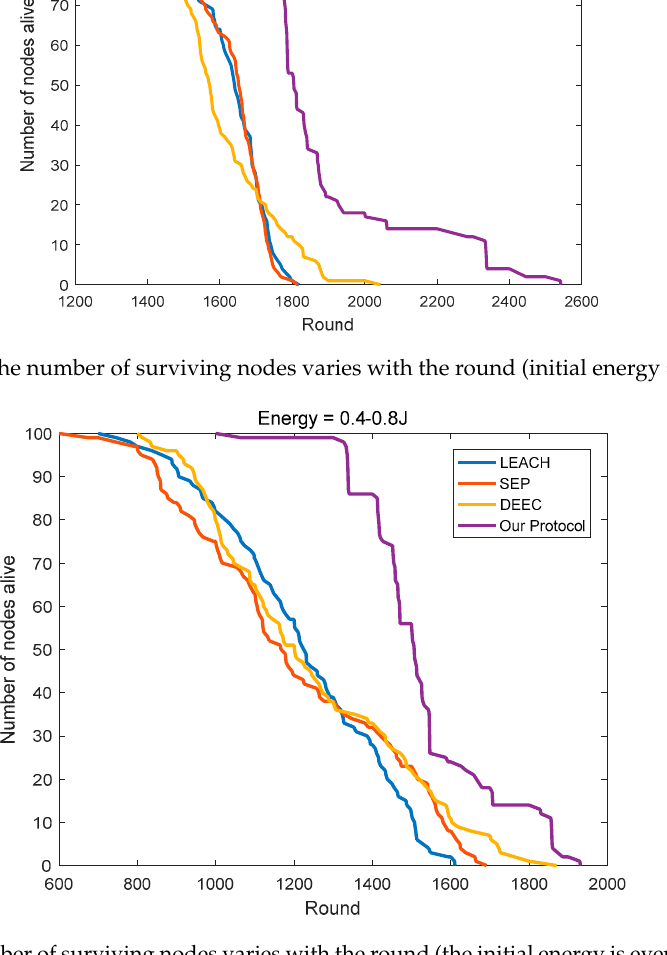
Figure 16. The number of surviving nodes varies with the round (the initial energy is evenly distributed at 0.4–0.8